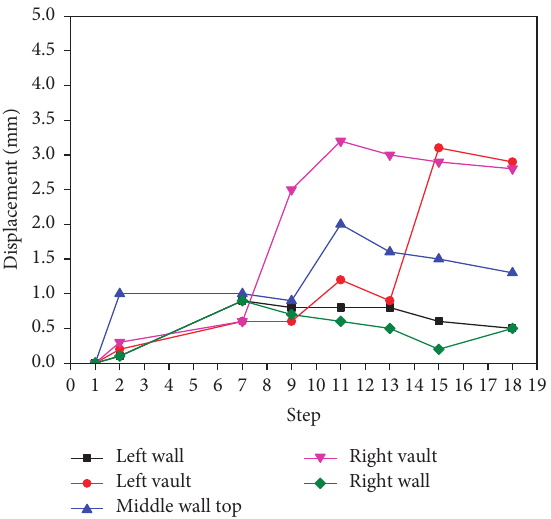
Figure 13: Displacement of scheme I. Figure 14: Displacement of scheme